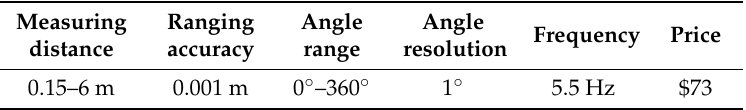
Table 1. The key parameters of